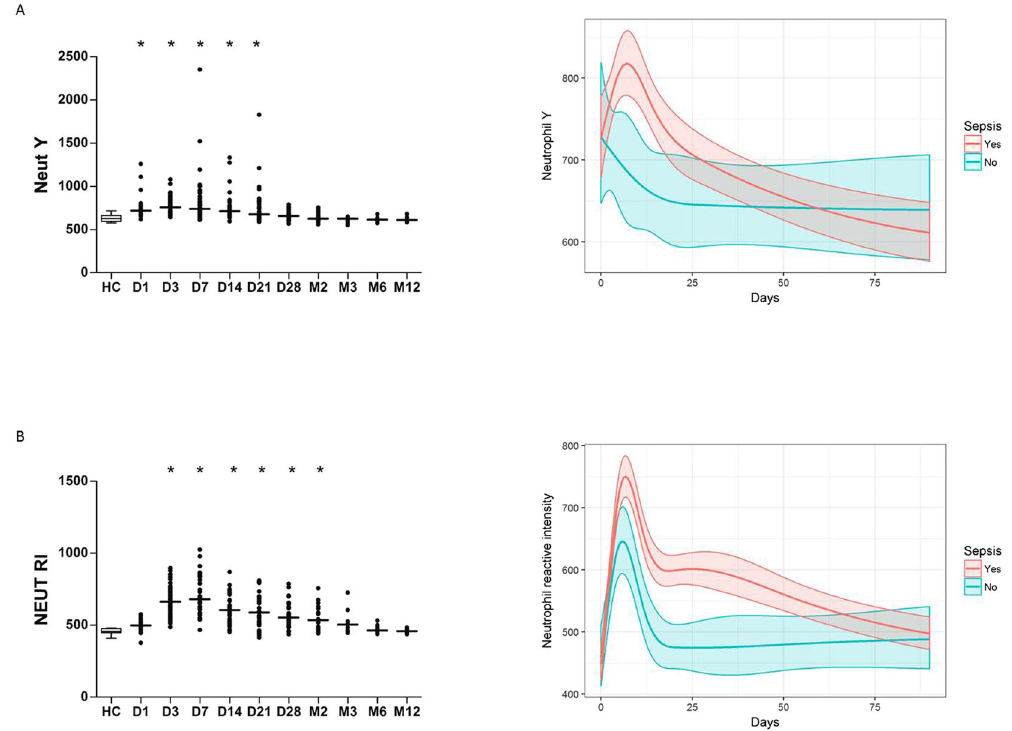
Figure 5. Burn injury results in a change of neutrophil phenotype and maturity. ( A ) Neut Y across time (n = 39). ( B ) neutrophil reactivity index (Neut RI) across time (n = 39). Differences in kinetics were compared to data from control cohort (n = 40) using a Mann-Whitney test; * p < 0.005. Longitudinal analyses were performed using linear mixed-effects models to examine the relationship between time and Neut Y or Neut RI count according to sepsis status (n = 39). Line represents predicted mean fixed effects; shaded area represents 95% confidence intervals.